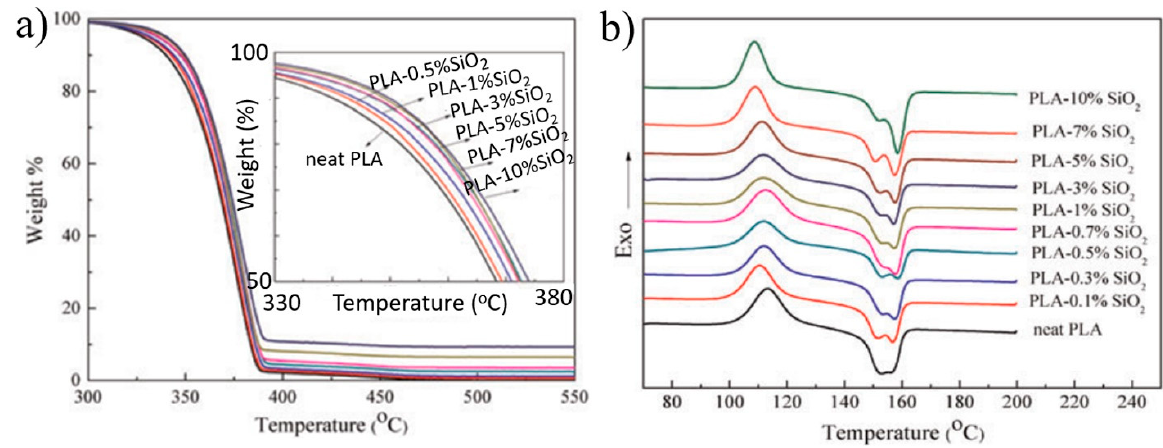
Figure 5. The effects of SiO 2 content on the thermal behavior of neat PLA and PLA/silica composites: ( a ) thermogravimetric analysis; ( b ) crystallization and melting behavior [64].